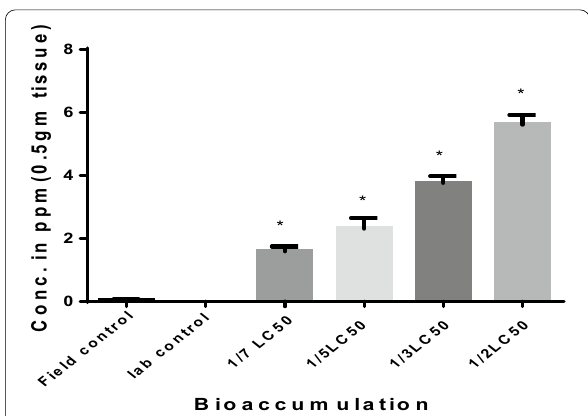
B io a c c u m u la tio n Fig. 4 The graph below represents the accumulation of CuNPs after 14 days of treatment. Graph is plotted as mean standard ±